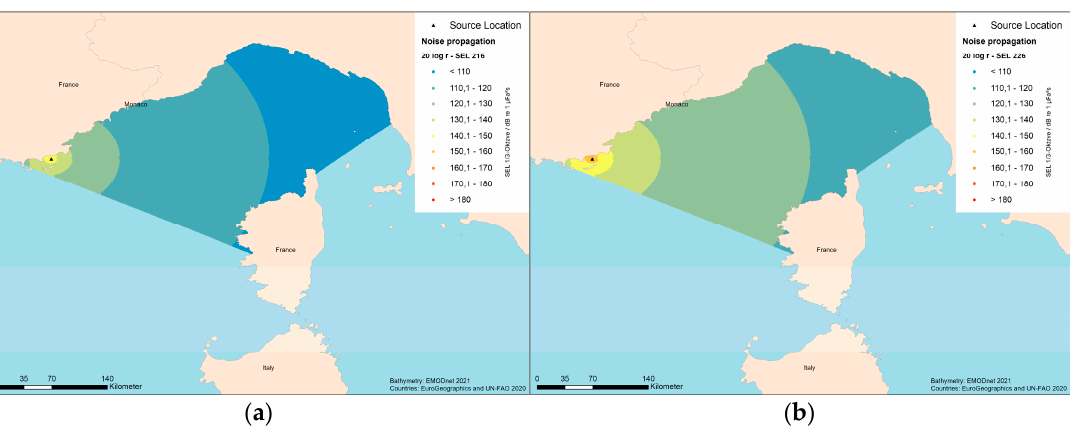
Figure A6. Pressure map due to an airgun array in the Mediterranean Sea, using (a) 20 log with ESL = 216 dB re 1 µPa 2 m 2 s and (b) 20 log law with ESL = 226 dB re 1 µPa 2 m 2 s.